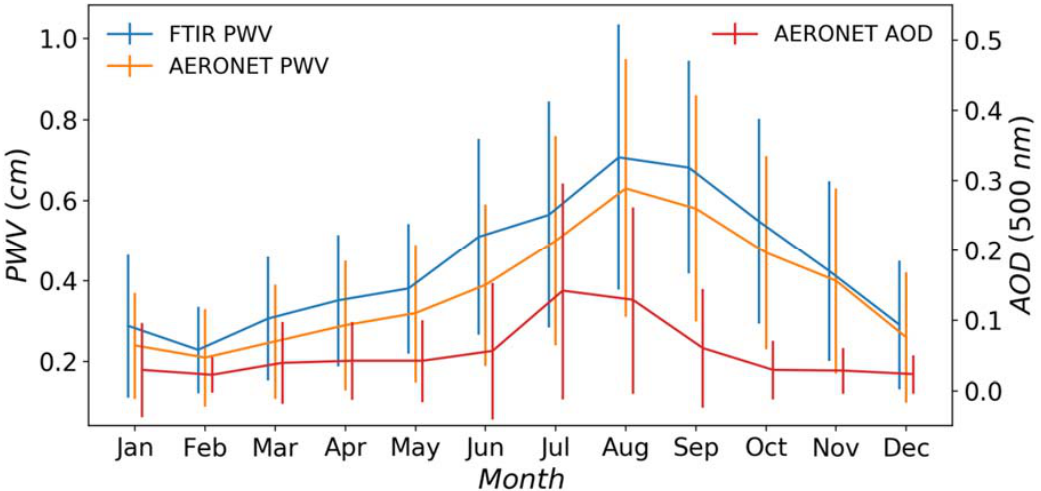
Figure 1. Monthly precipitable water vapor (PWV) and aerosol optical depth (AOD) 500 averages (solid lines) and corresponding standard deviations (error bars) at Izaña station. PWV annual cycle given by Total Column Carbon Observing Network (TCCON) Fourier Transform Infrared (FTIR) (blue line) has been calculated for 2007 ‐ 2019. Aerosol Robotic Network (AERONET) PWV (orange line) and AOD 500 (red line) have been calculated for 2005 ‐ 2019.